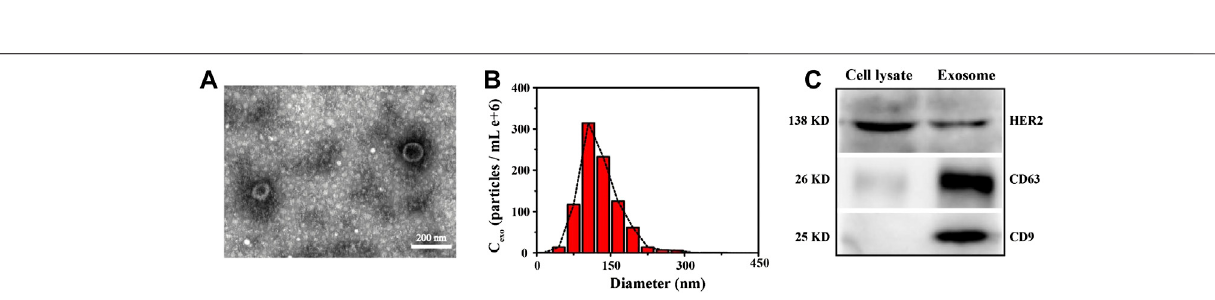
FIGURE 1 | Characterization of SK-BR3 cell exosomes by TEM (A) , NTA (B) and Western blot (C) , respectively. Scale bars = 200 nm. Cell lysate was set as a reference.